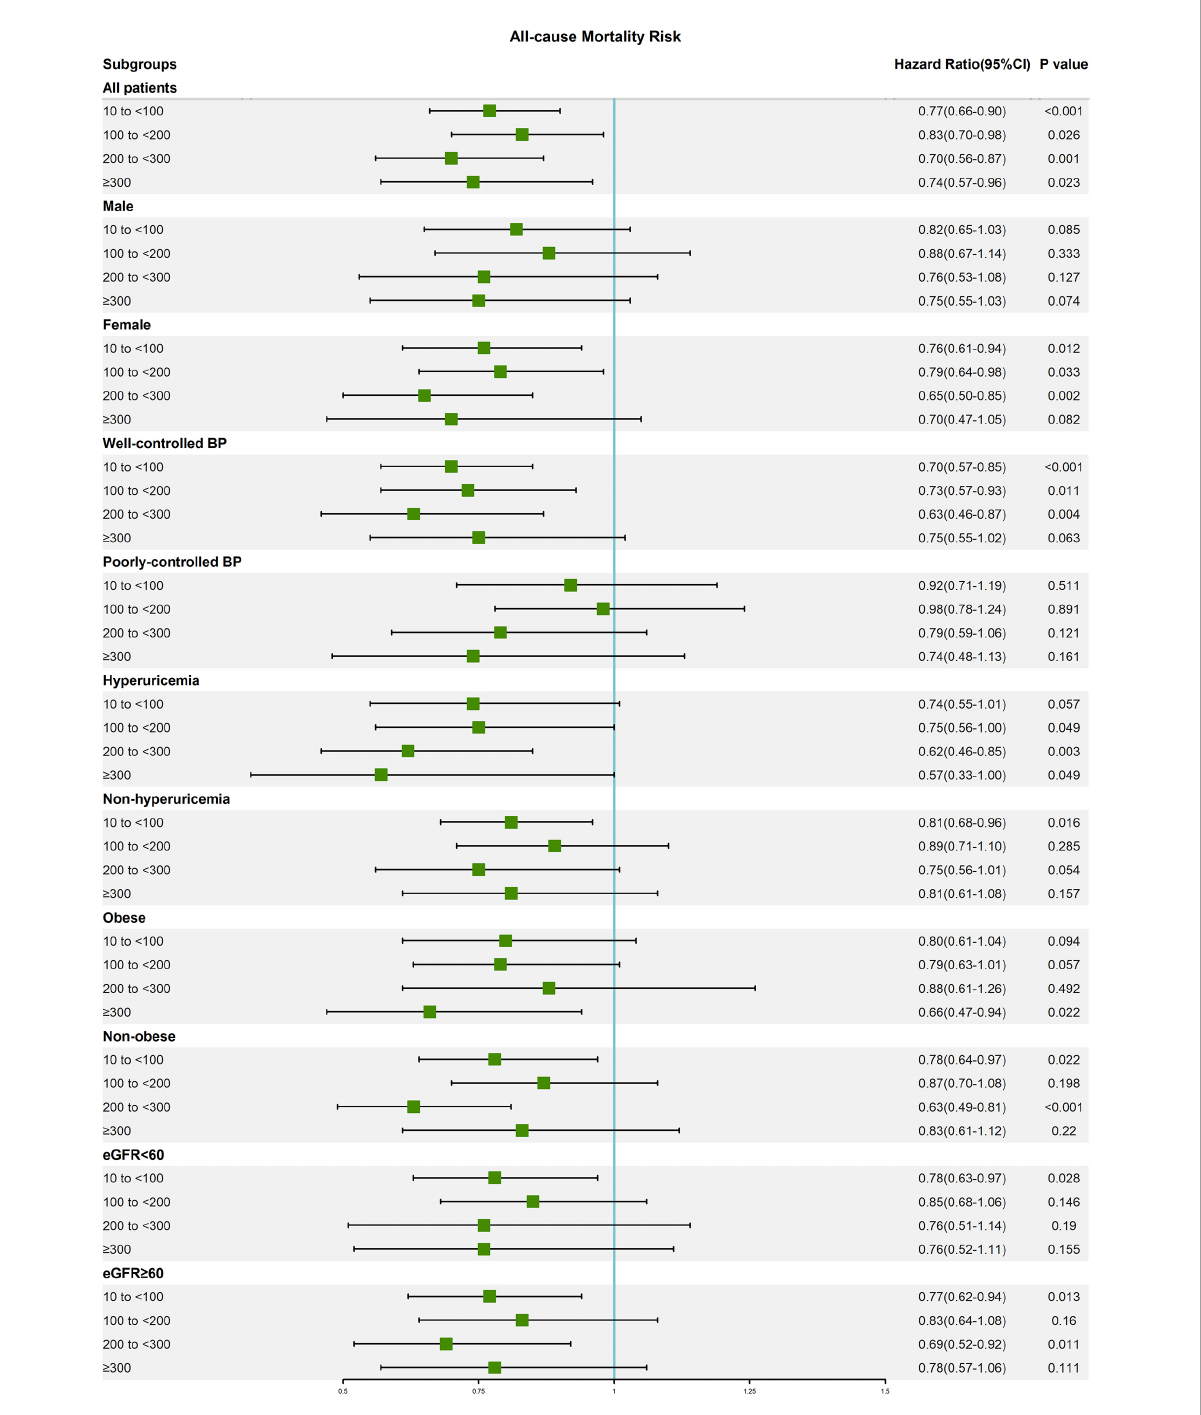
FIGURE2 Forest plot of multivariable model 3 hazard ratios for all-cause mortality in subgroup